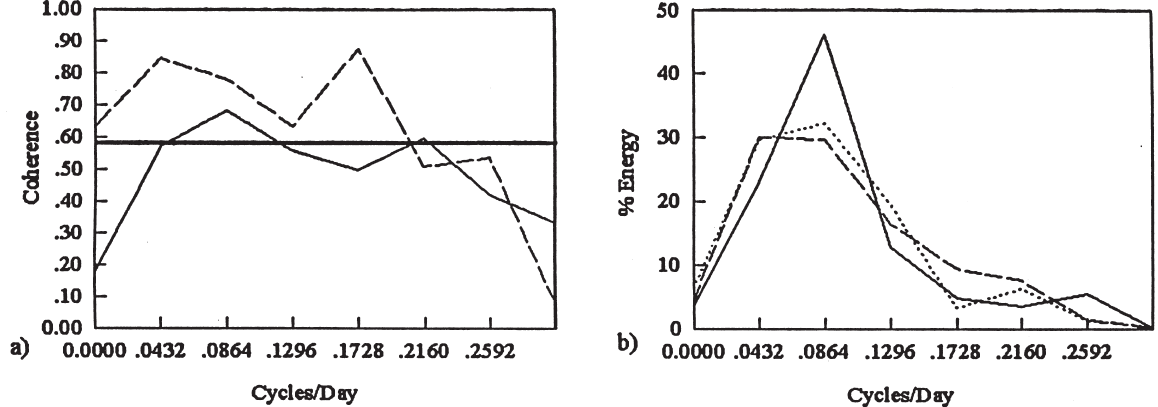
(t) , S (t) series and u (t) series at the mooring M3. a) coherence diagram; C l l l (t) (solid line), S (t) (dashed line) and u l l